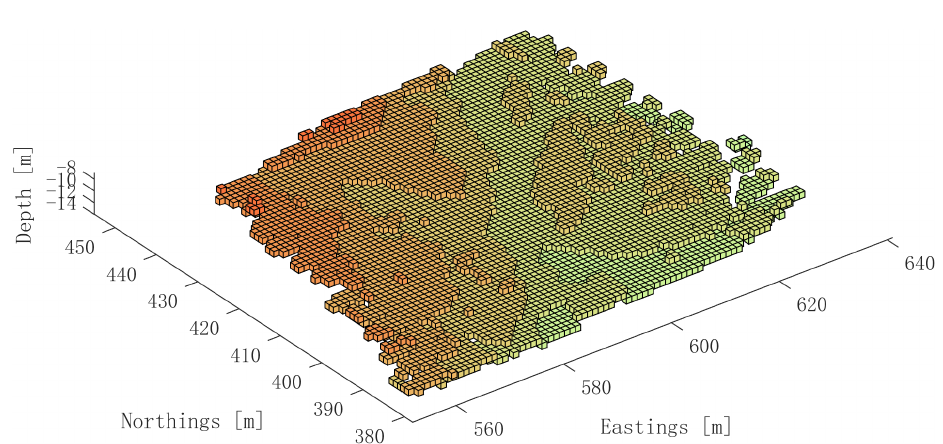
Figure 6. A representation of the test map as Octree-based map.